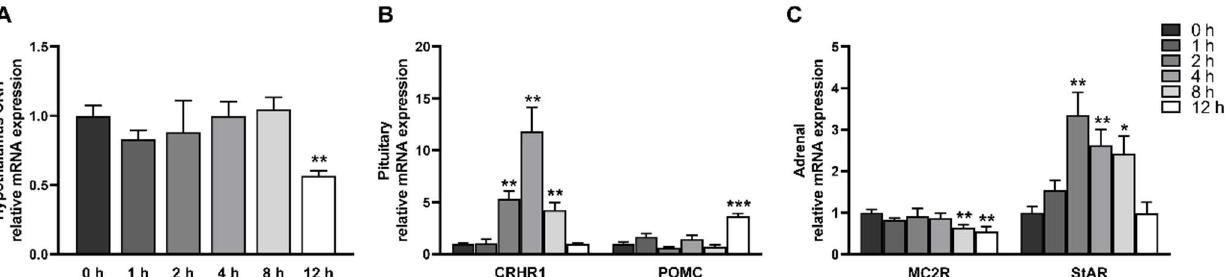
Figure 2. LPS increases the mRNA expression of important components in the hypothalamic-pitui- tary-adrenal axis: ( A ) CRH in the hypothalamus; ( B ) CRHR1 and POMC in the pituitarygland; and ( C ) MC2R and StAR in the adrenal gland. The pigs in LPS groups were injected with LPS at 100 µ g/kg BW, and then were sacrificed at 1, 2, 4, 8, or 12 h after LPS challenge. Values are means ± SEM, n = 6. * p < 0.05, ** p < 0.01, and *** p < 0.001, significantly different from the control group (0 h). CRH , corticotropin releasing hormone; CRHR1 , CRH receptor 1; POMC , proopiomelanocortin; MC2R , type 2 melanocortin receptor; StAR , steroidogenic acute regulatory protein.